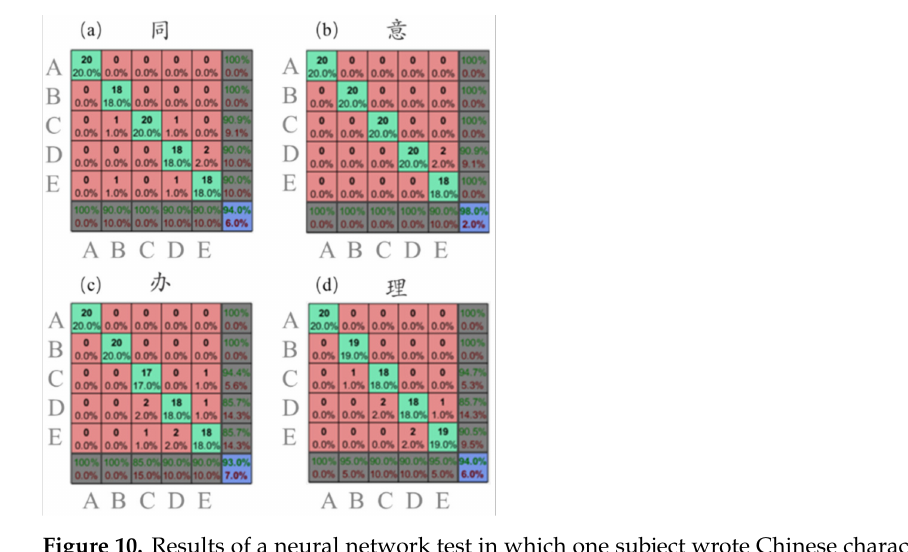
Figure 10. Results of a neural network test in which one subject wrote Chinese characters ( a ) “ 同 ” ( b ) “ 意 ” ( c ) “ 办 ” ( d ) “ 理 ” (means “agree to proceed”) in five different normative